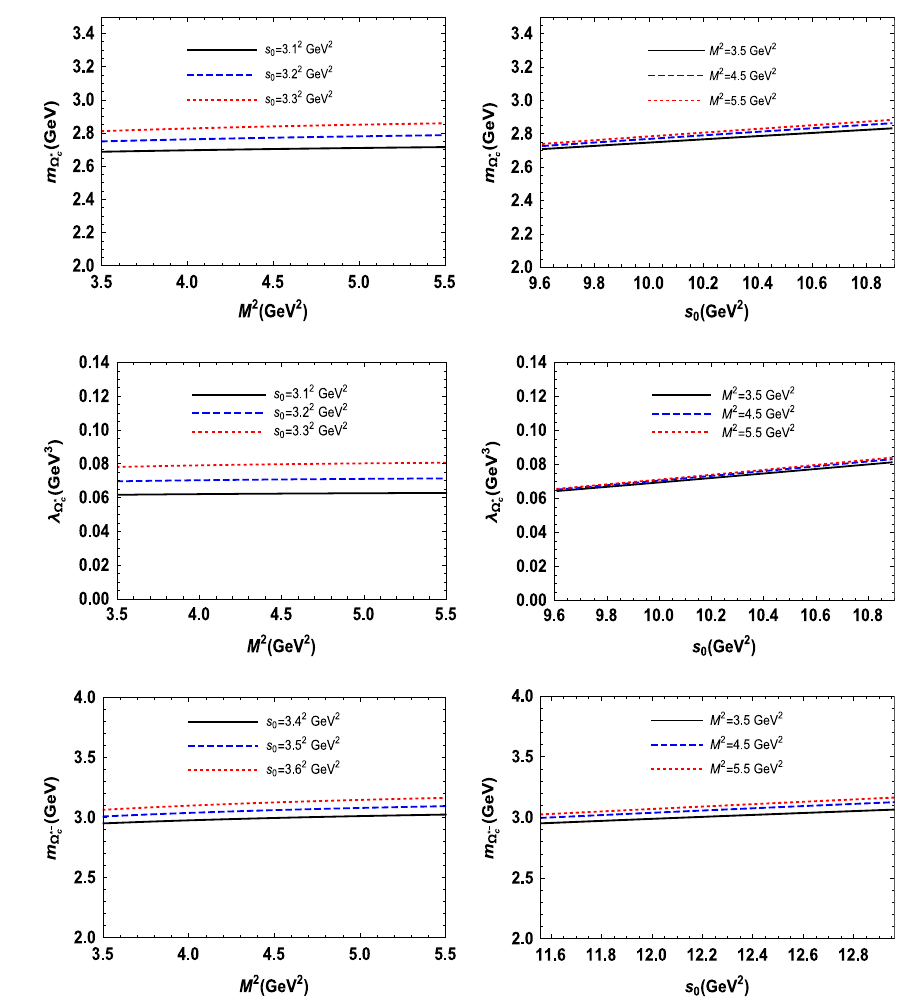
Fig. 3 The same as in Fig. 1, but for the orbitally excited (cid:2) (cid:4) − c